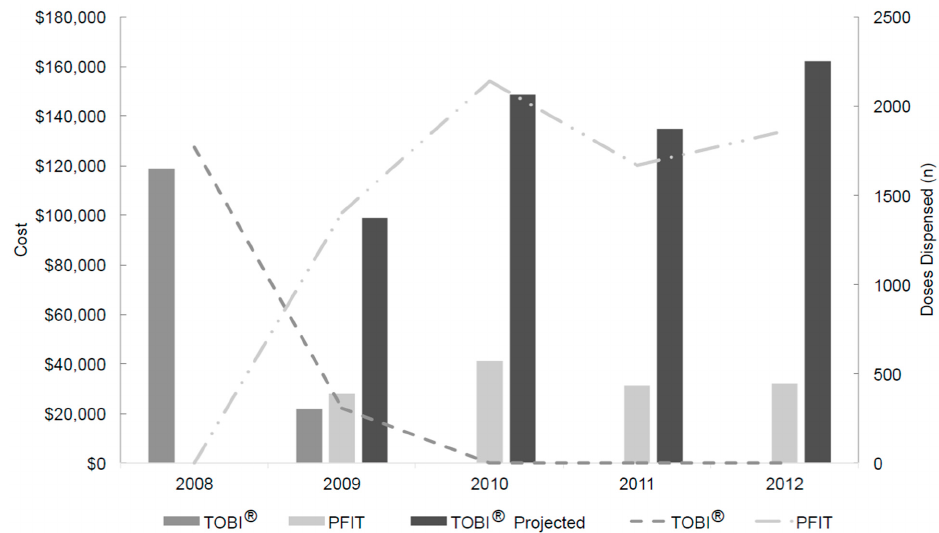
Figure 1. Inhaled tobramycin product utilization, actual costs and projected costs from 2008 through 2012, price-adjusted to 2013 US dollars a